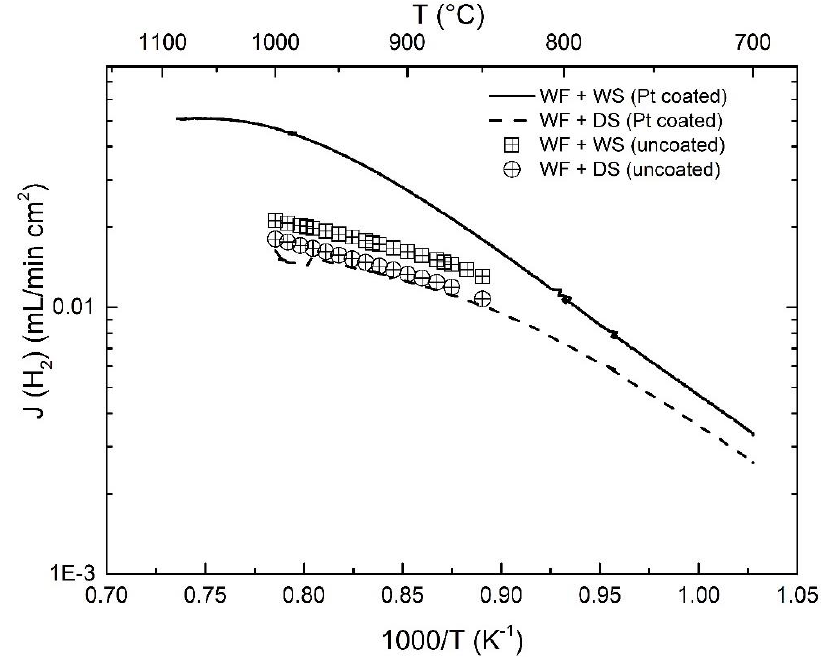
Figure 3. Comparison of hydrogen flux as a function of temperature for Pt-coated and uncoated tubular membranes. The half open labels correspond to the asymmetric tubular membrane without any coating [27]. The sweep Ar flow rate is 25 mL/min.